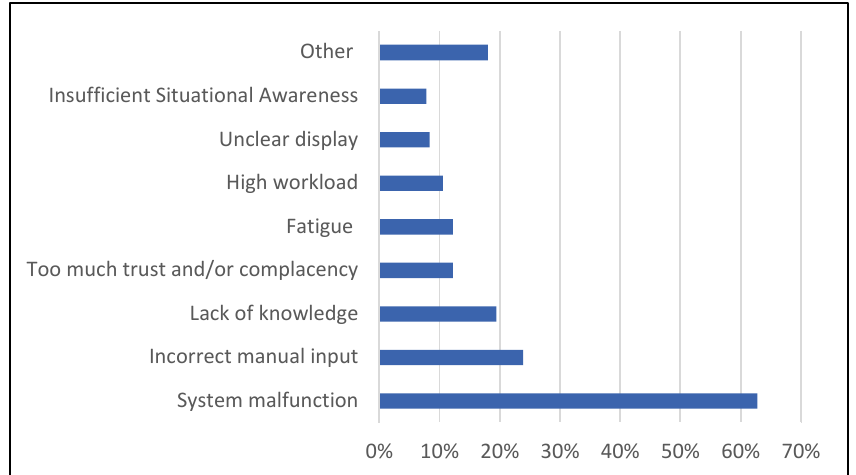
Figure 4. Responses to the question what the cause was of the last AS-event that was experienced. Multiple answers were possible and a total of 315 responses were given to identify causes that played a role in the 180 AS-events reported, therefore the total exceeds 100%. System malfunction is interpreted as a lack of understanding of the system, because of the high reliability of aviation systems, the tight coupling of the modules of cockpit automation, the interface design choices and the use of automation in aviation that is above the critical boundary of action selection.